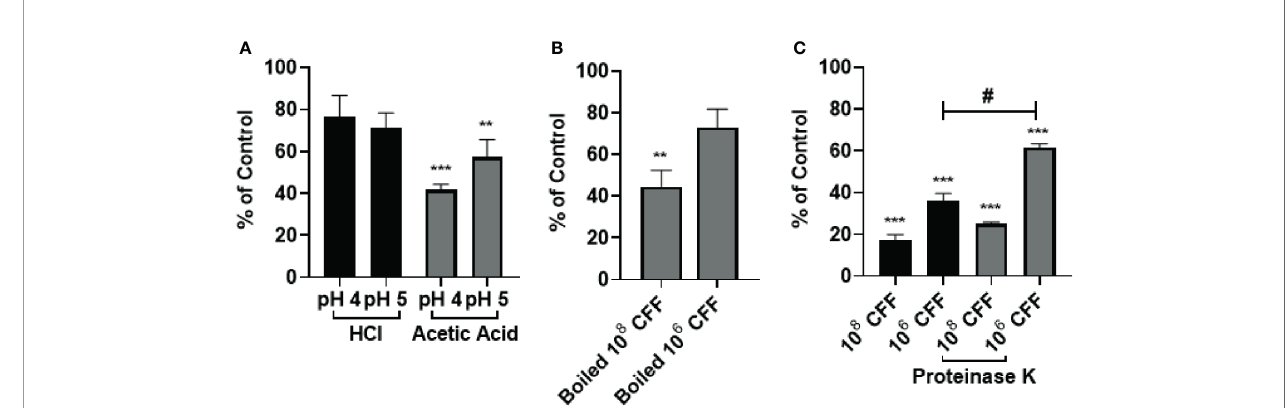
FIGURE 3 | The anti-bio fi lm effects of L. acidophilus cell free fi ltrate (CFF) were not due to acidity per se. (A) HCl and acetic acid pH matched to 10 8 and 10 6 CFF (pH 4 and 5, respectively), was added to 20 h established bio fi lm for 6 h HCl did not reduce P. aeruginosa bio fi lm at either pH tested. Acetic acid (pH 4 and pH 5) removed approximately 60% and 40% of 20 h established bio fi lm. (B) L. acidophilus 10 8 and 10 6 CFF was boiled at 100°C for 15 min to denature proteins. The boiled CFF was added to 20 h established bio fi lm for 6 h. 10 8 boiled CFF signi fi cantly reduced established bio fi lm but 10 6 CFF did not. (C) 100 µg/mL Proteinase K was added to the CFF at 37°C for 1 h and then inhibited with 1 mM PSMF. The protein digested CFF was added to 20 h P. aeruginosa bio fi lm for 6 h. Both concentrations of CFF digested with Proteinase K signi fi cantly removed 20 h P. aeruginosa bio fi lm. With low concentration CFF however, Proteinase K reduced the anti-bio fi lm activity of the CFF. Data are mean ± s.e.m. of percent from control. **p < 0.01, ***p < 0.001 compared to control; # p < 0.05 compared to 10 8 CFF control; HCl and acetic acid n = 4 independent experiments; boiled CFF n = 3 independent experiments; Proteinase K n = 4 independent experiments.